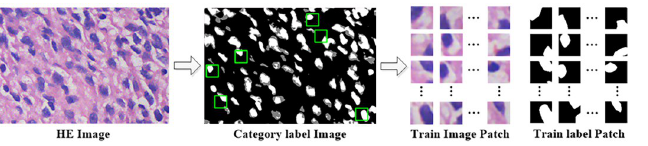
Fig 3. Training image patch collection process. Where the white areas in the category label image are the nuclear stable color areas, the gray areas are the fuzzy areas, the black areas are the nonnuclear areas, and the green boxes indicate the areas selected as the